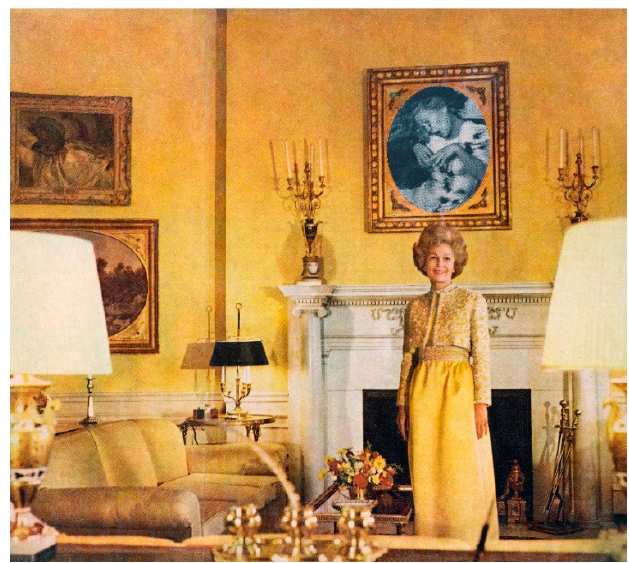
Figure 9. Martha Rosler, First Lady (Pat Nixon) , from the series House Beautiful: Bringing the War Home , c. 1967–1972. Photomontage. © Martha Rosler/Courtesy of the artist and Mitchell ‐ Innes & Nash, New York.